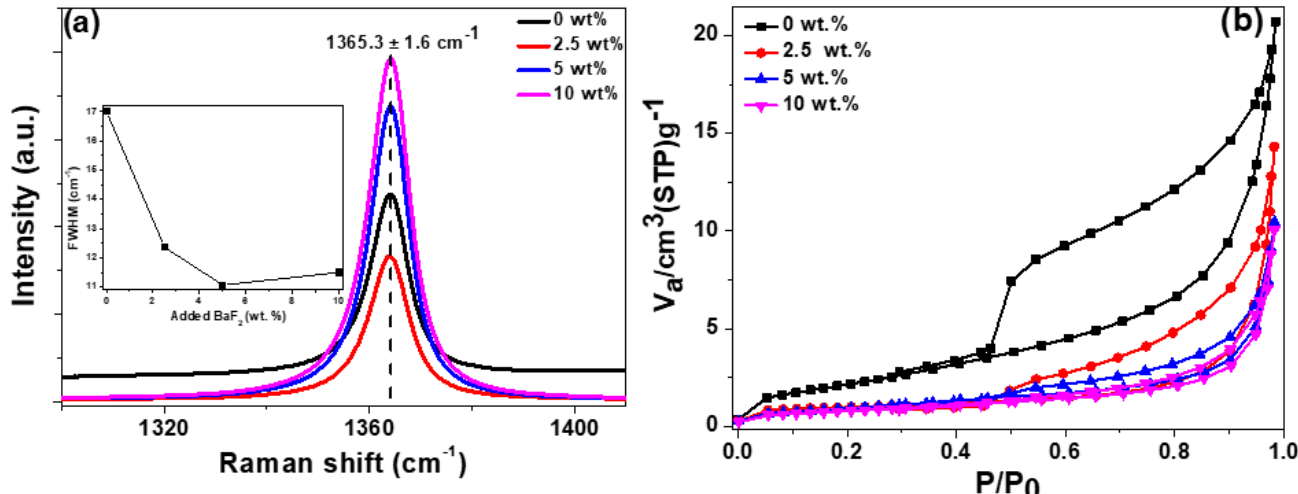
Figure 2. ( a ) Raman plots and ( b ) adsorption isotherms of pristine and 2.5, 5, and 10 wt% BaF 2 -modified h BN samples. Inset: bandwidth of the Raman spectra as a function of BaF 2 wt% [28] .